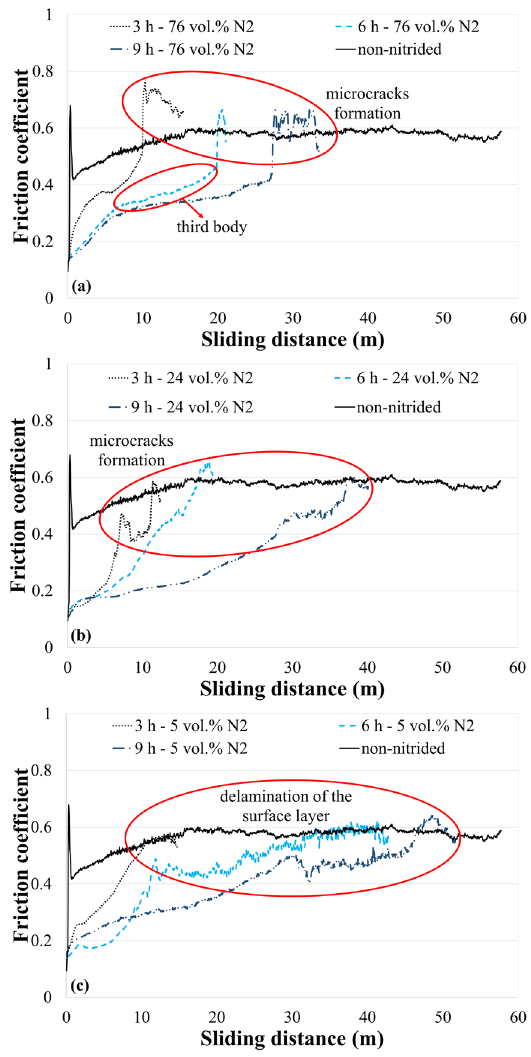
Figure 7. Friction coefficient obtained in reciprocating dry sliding wear tests on non-nitrided and plasma nitrided samples for with gas mixture composition of (a) 76 vol.% N (c) 5 vol.% N